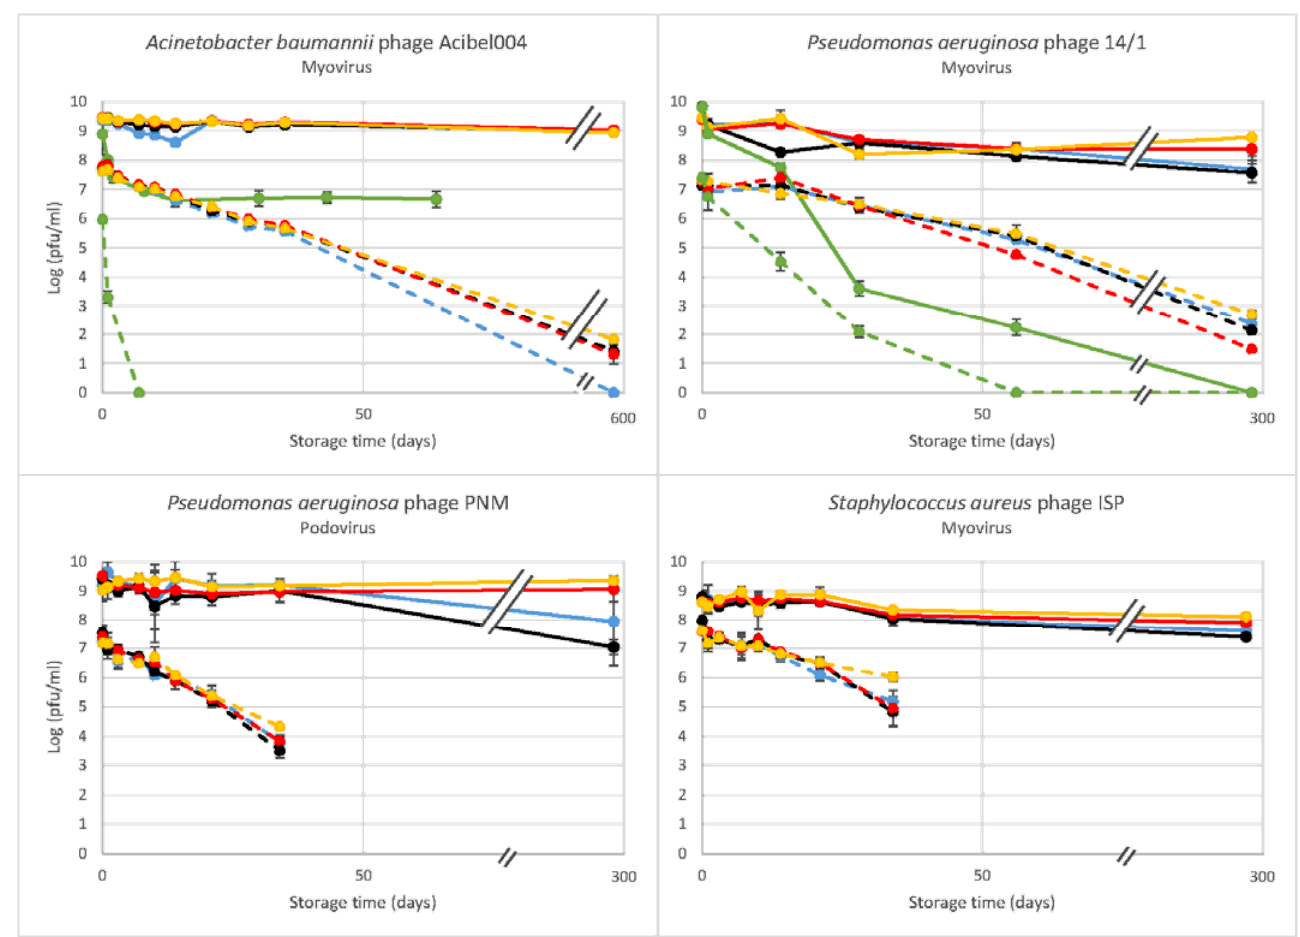
Figure 1. Stability over time of the infectivity of different phages, stored at 4 °C at two different concentrations: 9 log pfu/mL (solid lines); 7 log pfu/mL (dotted lines). Phages were suspended in 5% glucose (green), 0.9% NaCl (blue), Hartmann solution (black), DPBS w/ Ca 2+ and Mg 2+ (red), and DPBS w/o Ca 2+ and Mg 2+ (yellow). Infectivity was determined by the double agar overlay method. The results are the mean values of triplicate samples of each phage at each concentration in each solution. Standard deviations are indicated. Average standard deviations of Acibel004; 14/1; PNM and ISP are 0.06; 0.15; 0.26 and 0.18, respectively. For phage ISP results were from an 8.8–8.9 log pfu/mL sample.